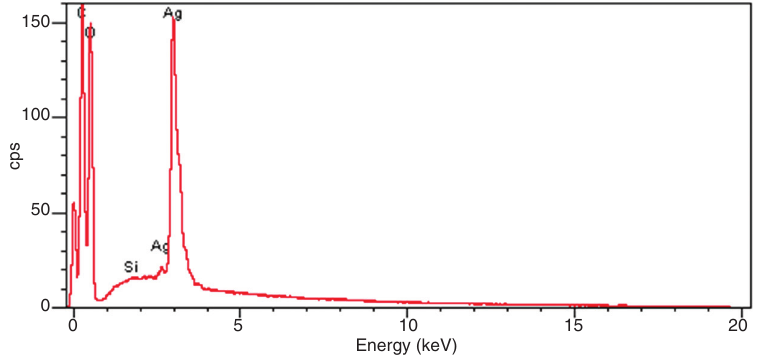
Figure 3 Energy dispersive X-ray analysis of silver-polyvinyl alcohol nanocomposite.